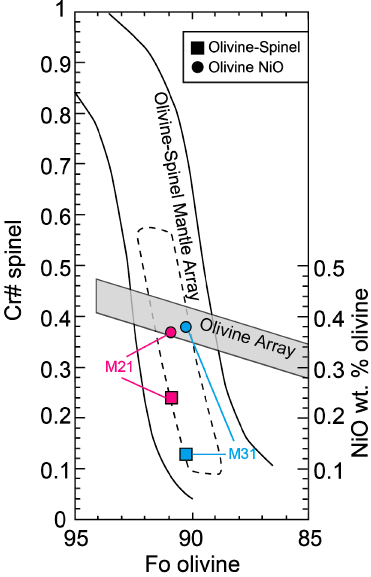
Figure 6. Compositional relationships between the Fo and NiO contents of olivine, and the Fo content of olivine and the Cr# of coexisting spinel. Mantle Olivine Array (Olivine Array in the diagram) is from [21]. Olivine-Spinel Mantle Array shows the compositional range for residual peridotites in spinel peridotites [22,23]. Compositional ranges of the OSMA for the Middle-North Andaman peridotites [11] are also shown in a dashed line.